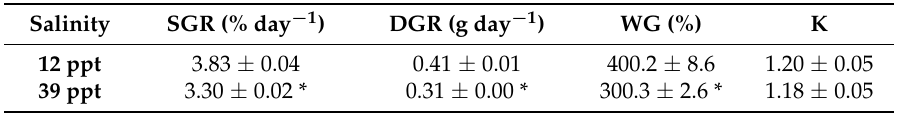
Table 1. Growth-related parameters in Argyrosomus regius fingerlings acclimated to 12 and 39 ppt salinity conditions for 45 days. SGR: Specific growth rate; DGR: Daily growth rate; WG: Weight gain; K: Fulton´s condition factor. Data are expressed as the mean ± SEM (n = 120). Asterisks (*) indicate significant differences among groups ( p < 0.05, Student’s t